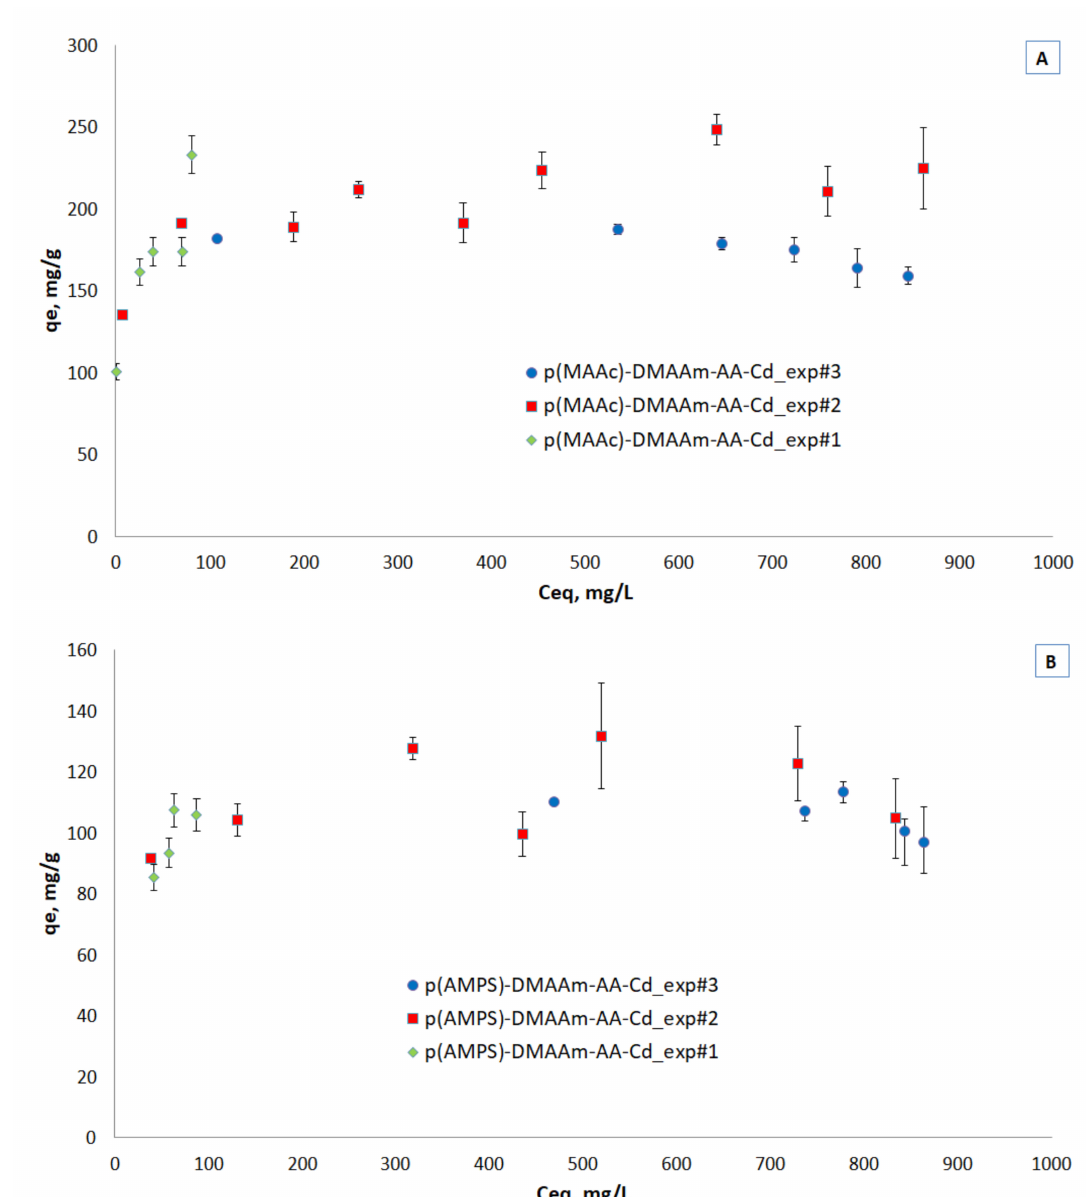
Figure 6. Isotherms of metal ions removal by ( A ) p(MAAc)-DMAAm-AA and ( B ) p(AMPS)- DMAAm-AA